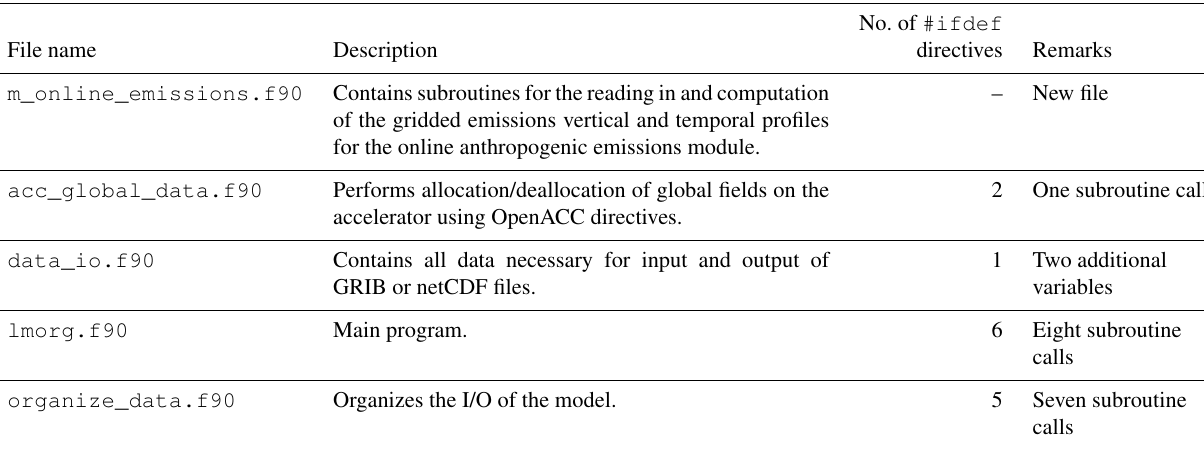
Table 1. Changes due to the GHG extension in the COSMO code